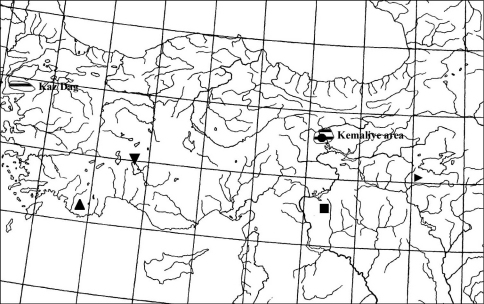
 Distribution map. ▲ Vitrea gostelii sp. n. ● Turanena demirsoyisp. n. and Rhabdoena gosteliisp. n. ■ Euchondrus paucidentatus sp. n. ▼ Metafruticicola kizildagensis sp. n. ► Assyriella thospitis menkhorsti ssp. n.